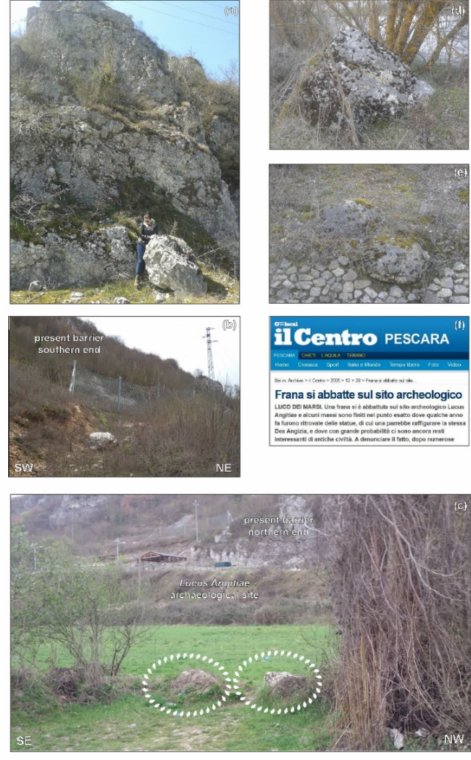
Figure 2. Example of calcareous rock blocks which can be observed in different parts of the study area. Specifically: ( a , b ) within the archaeological site; ( c ) along road lr_3; ( d ) in the middle sector of the slope, blocked by a tree; and ( e ) nearby a wall along the lr_1 roadside; ( f ) local newspaper reporting information about the rockfall event occurred in December